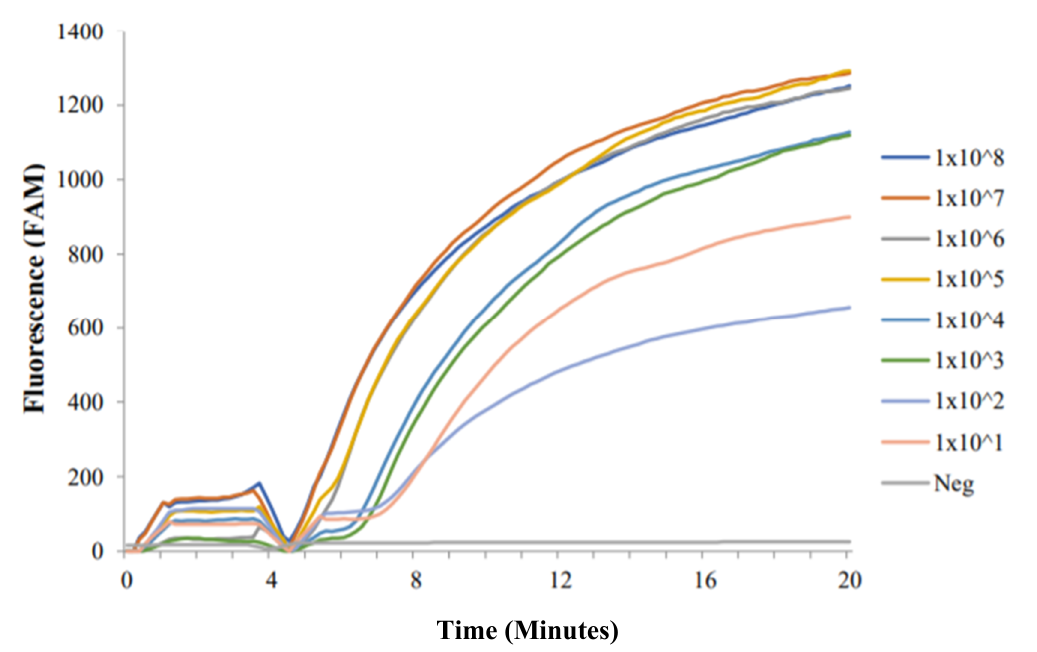
Time (Minutes) Figure 1. Commercially synthesised Dra1 fragment amplification profiles using RT-ShDra1-RPA assay. All dilution concentrations were successfully detected and amplified. The negative ddH 2 O control (‘Neg’) did not amplify. A temporary reduction in fluorescence was seen at minutes 4–5 as samples were removed to resuspend reagents and then promptly returned to the testing device.